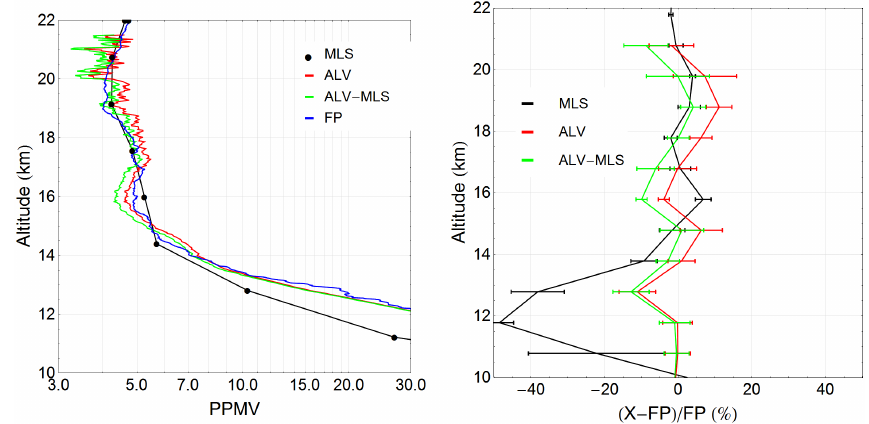
Fig. 5. (Left) Mean profiles of MLS, ALVICE (best estimate) and ALVICE (with correction based on MLS climatology) and FP for all data available during the MOHAVE campaign. (Right) Mean normalized differences in 1-km thick layers of MLS, ALV-best estimate, ALV-MLS corrected with frostpoint hygrometer using the same data as on the left.